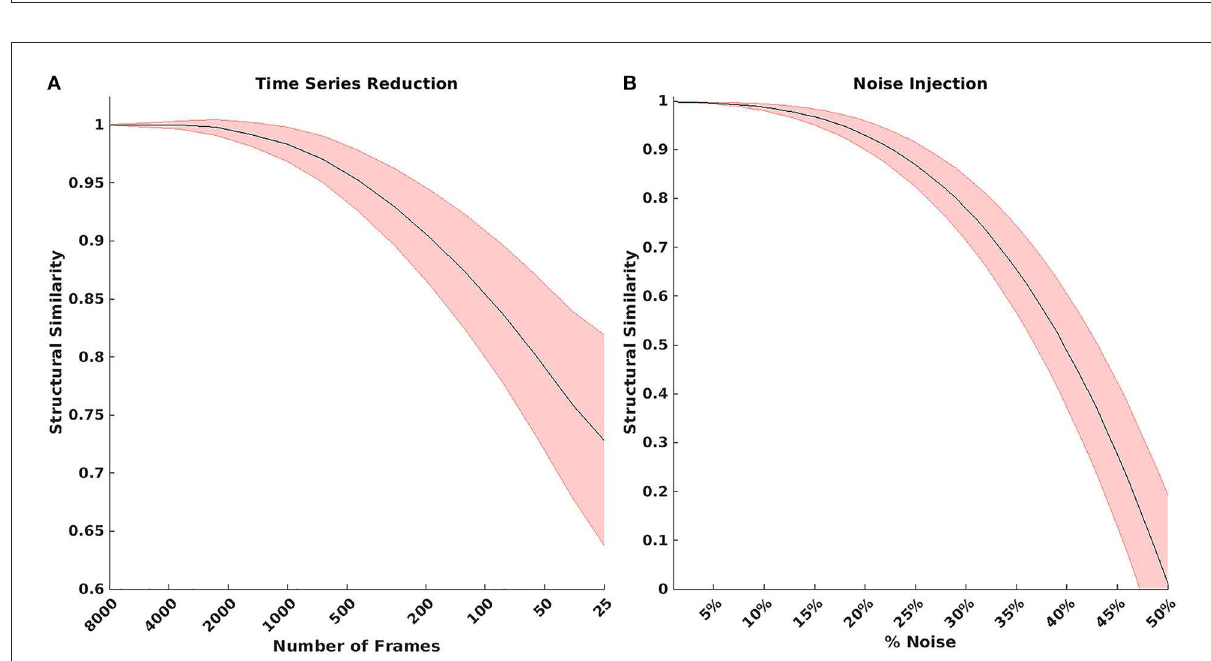
FIGURE3 (A) Result of reducing the total number of BOLD time points. On average, the model maintained a 0.9 structural similarity when comparing 8,000 time points to ∼ 150 time points. (B) Structural similarity when comparing model results with various amounts of noise added to the BOLD signal. The model maintained 0.9 structural similarity even after injecting 25–30% noise in the original bold signal.